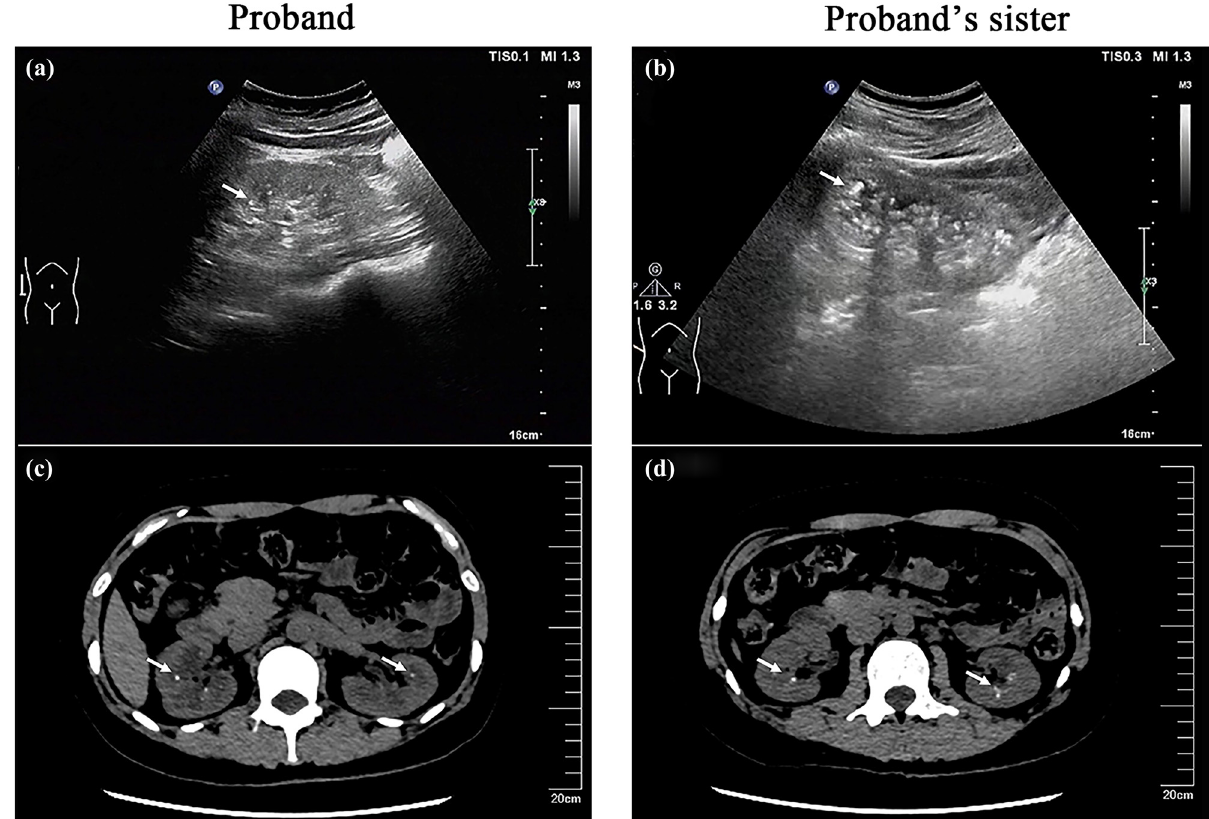
Figure 1: Imaging examinations of the kidneys for the proband and her sister. ( a and b ) Color Doppler ultrasonography of the kidney of the patient and his sister respectively; ( c and d ) 16 row spiral Computed Tomography scan images of the patient and her sister respectively. Multiple small stones were found in both kidneys. The arrow designates the